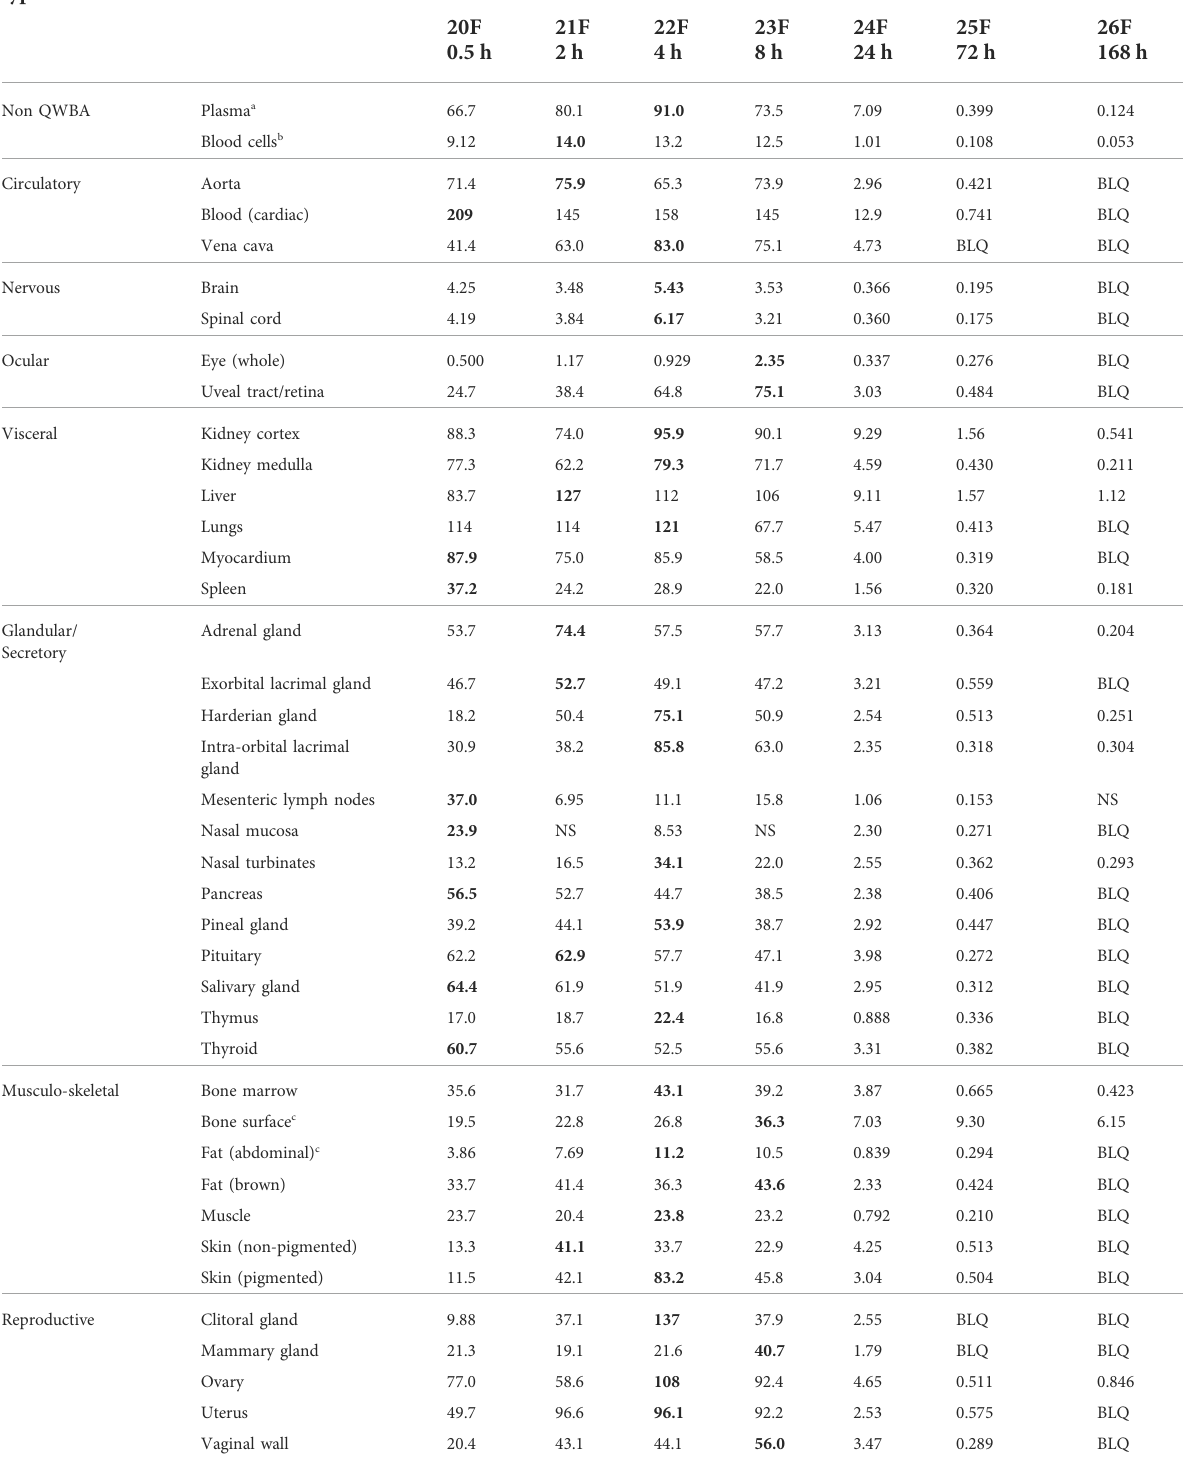
TABLE 6 Concentrations of radioactivity in tissues determined by QWBA following a single oral administration of [ 14 C] zapnometinib (30 mg/kg) to female partially pigmented rats (Group 3). Tissue